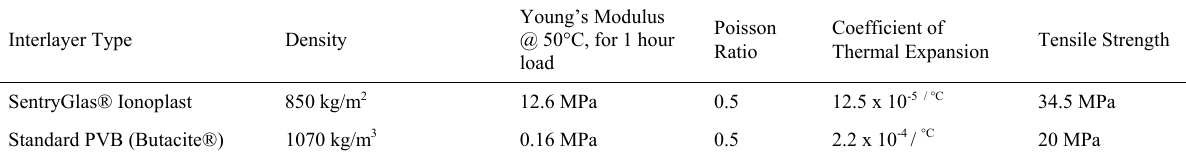
Table 1: Comparison of Mechanical Properties of SentryGlas® and Standard PVB